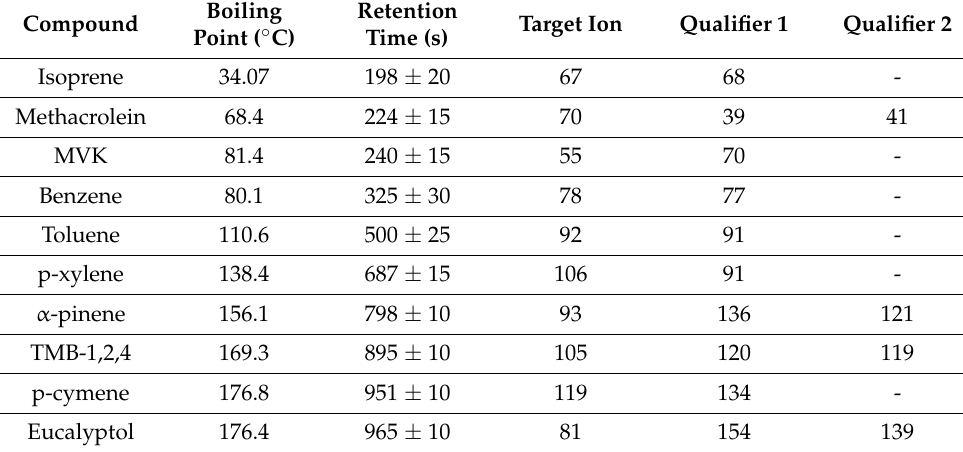
Table 1. Selected ions used to detect targeted compounds in SIM mode during the sampling period. The target ion was used to estimate concentrations and uncertainties. The qualifier ions (1 and 2) were used to confirm the identity of the compound in the chromatogram. Retention times (in seconds) are for an initial oven temperature of 35 ◦ C. Ions were selected using the NIST library [50]. Compound Point ( ◦